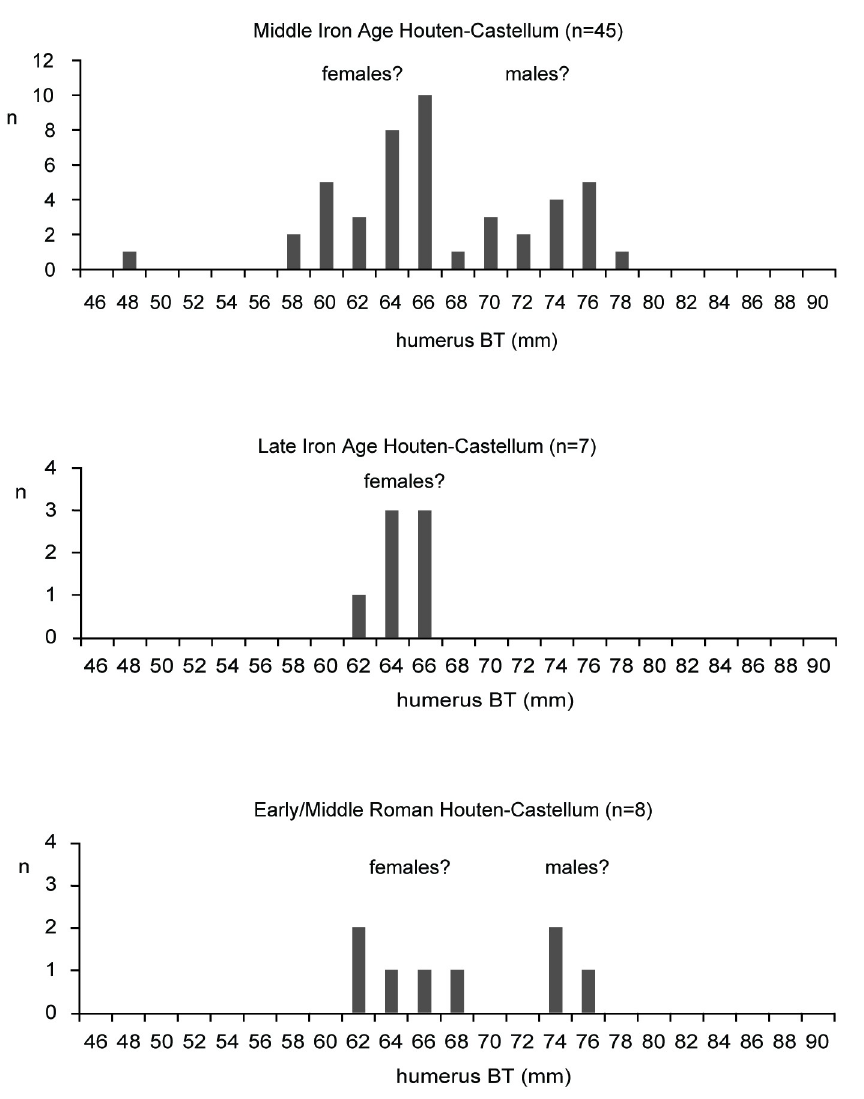
Fig 6. Houten-Castellum. Cattle: breadth of the trochlea of the humerus.